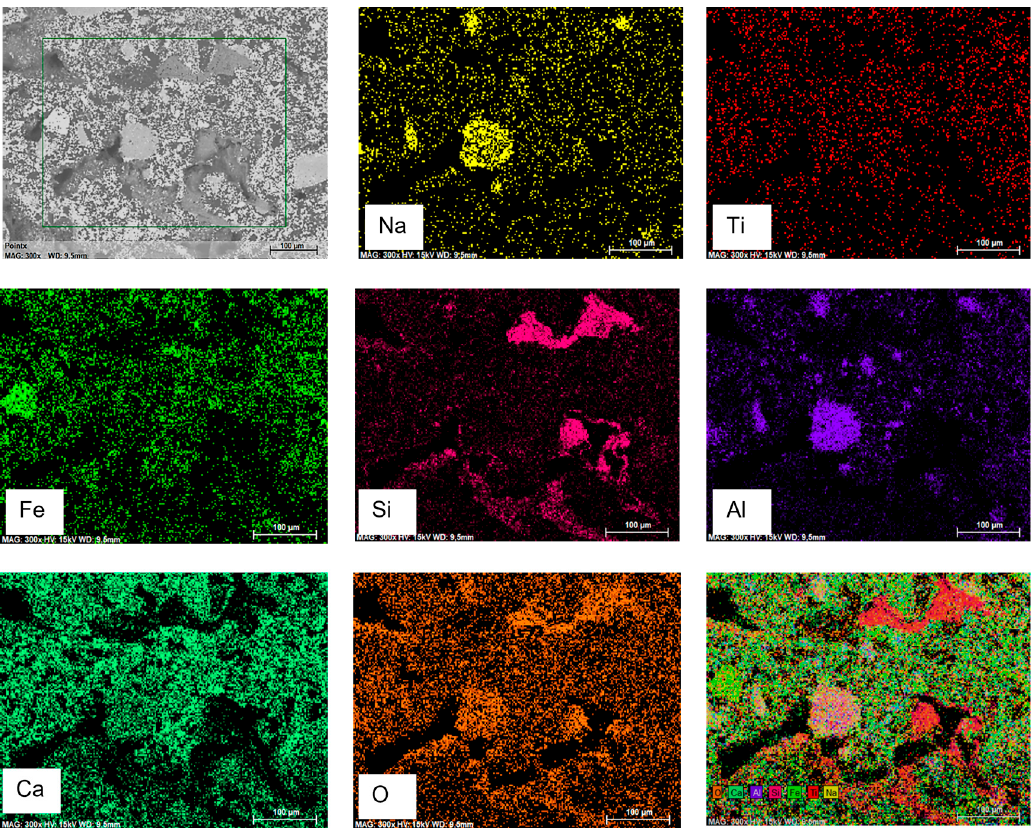
Figure 13. SEM image and EDS analysis of reduced sample RH5.